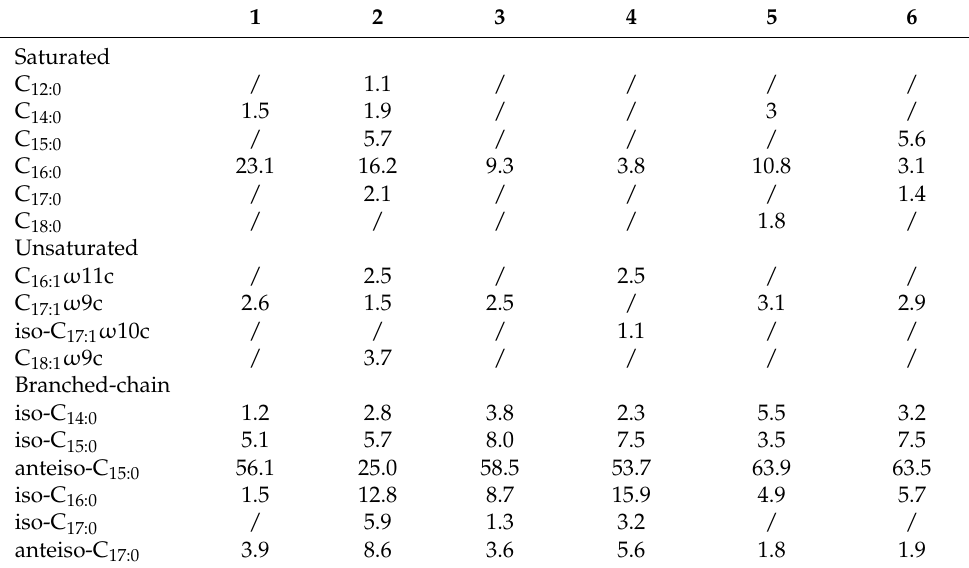
Table 2. Cellular fatty acid compositions (%) of novel strains and the type of strains of the most closely related Paenibacillus